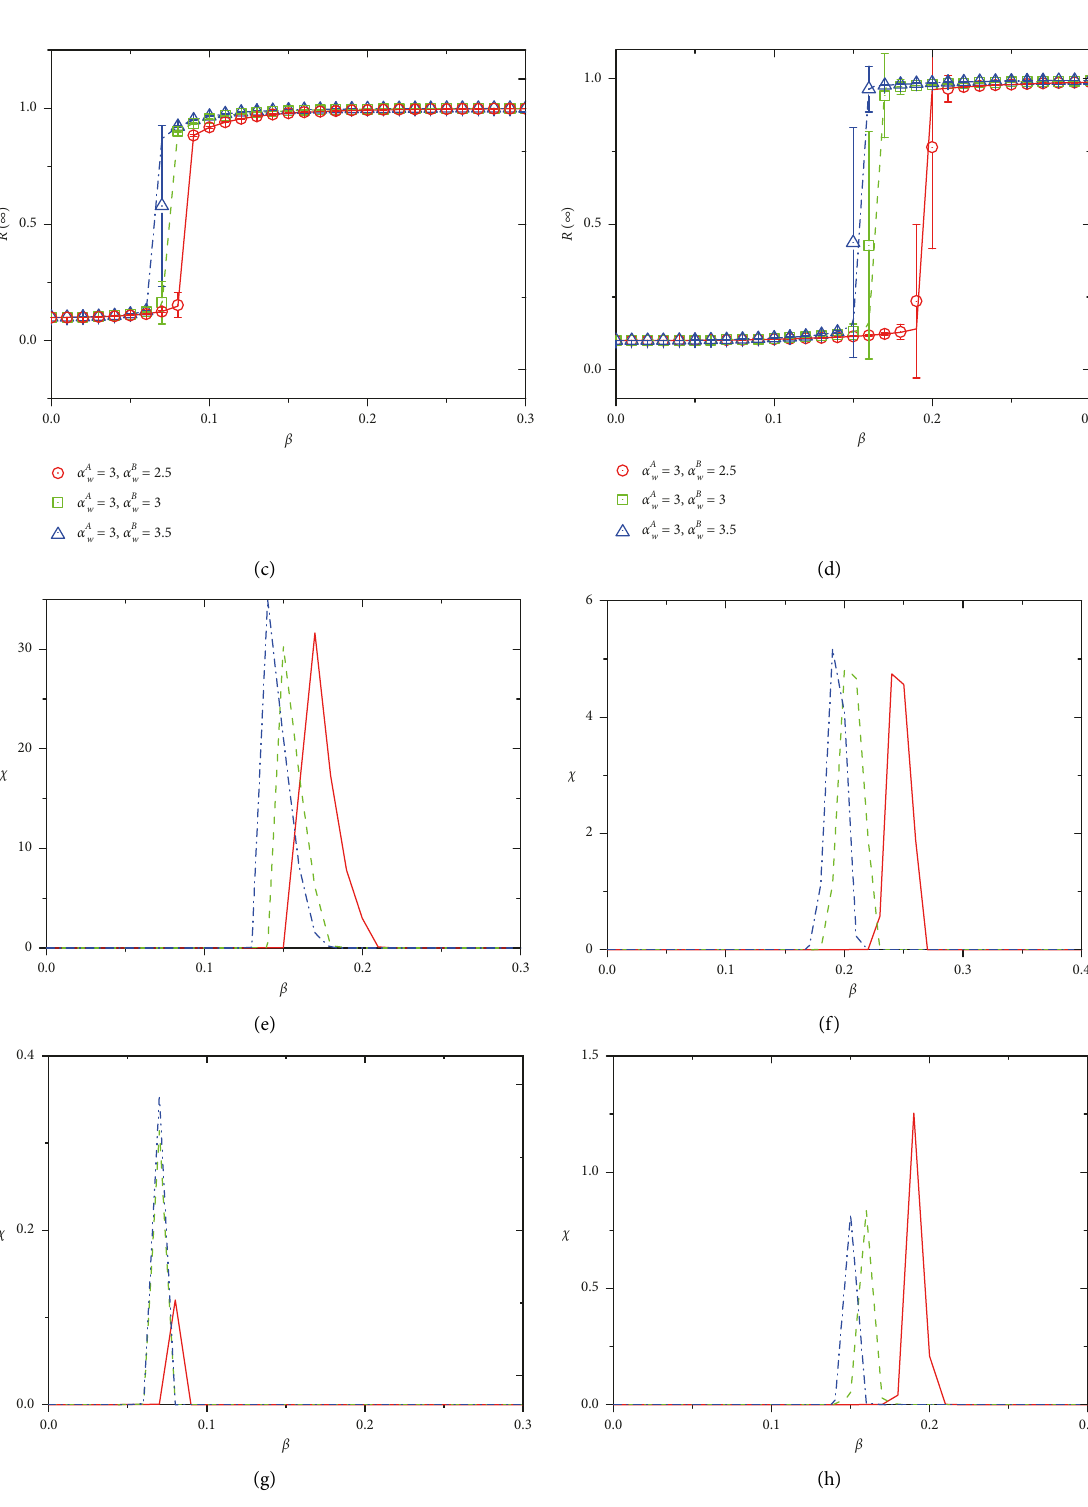
Figure 3: Growth pattern of the final adoption size R ( ∞ ) versus information transmission unit probability β on the ER-ER weighted multiplex and α B , given adoption thresholds ( T A , T B ) and initial fraction ρ of seeds. The final network, under different weight distribution exponents α A 0 ω ω � 0 . 005, (b) T � 1 ; T � 2 ; ρ � 0 . 03, (c) adoption size R ( ∞ ) versus information transmission probability β with (a) T A � 1; T B � 1; ρ A B 0 0 � 1 ; T � 2 ; ρ � 0 . 1, and (d) T � 1 ; T � 3 ; ρ � 0 . 1. The lines denoting theoretical solutions agree exceptionally well with the symbols T A B A B 0 0 representing numerical simulations. Moreover, in subgraphs (e), (f), (g), and (h), the relative variance χ in terms of the peaks numerically indicates the critical spreading probabilities in (a), (b), (c), and (d), respectively, showing that increasing the weight distribution exponent (decreasing weight distribution heterogeneity) can decrease the critical spreading probability. The phenomena above suggest that decreasing weight distribution heterogeneity facilitates information spreading but cannot alter the growth pattern of the final adoption size versus information transmission probability. The basic parameters are N � 10 4 , 〈 k 〉 � 10, 〈 ω 〉 � 8, and c � 1 .